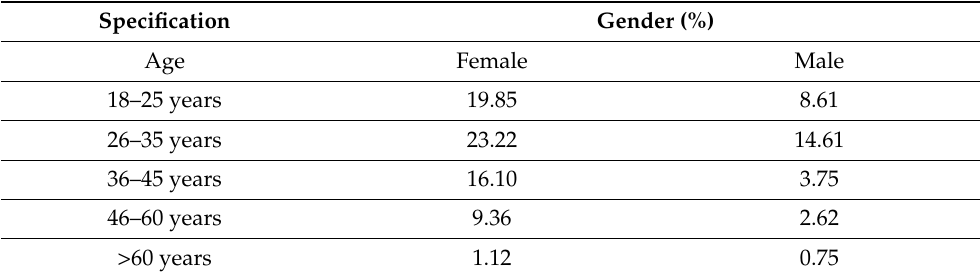
Table 1. Division by age categories, depending on gender, %.